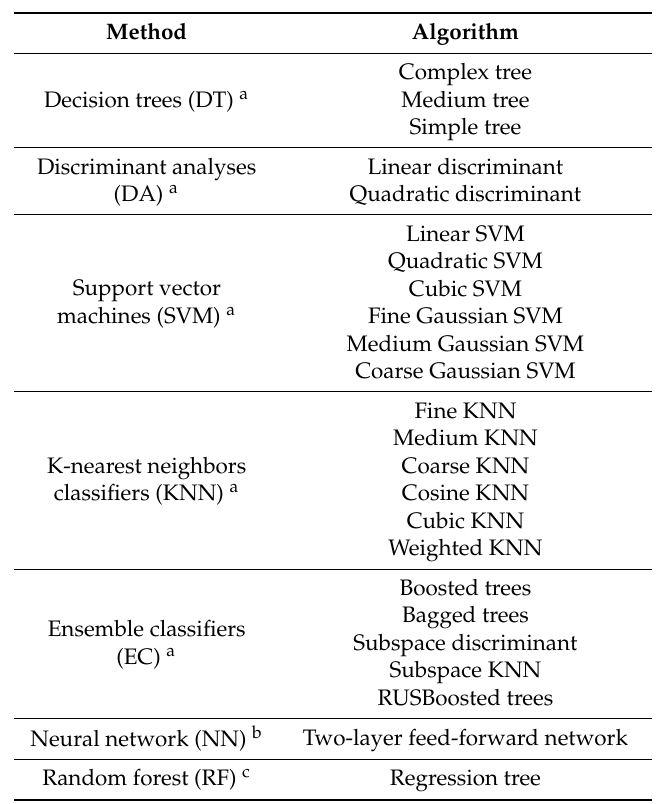
Table 3. Classification methods with different algorithms used in this